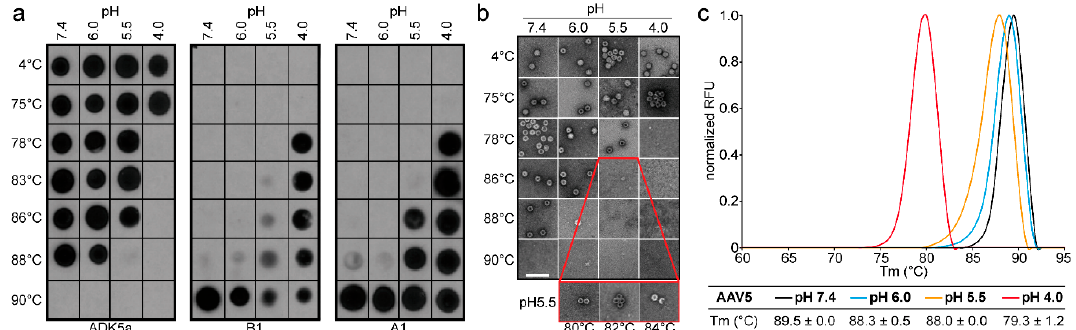
Figure 3. AAV5 stability analysis. ( a ) Dot immunoblots of AAV5-GFP vectors at different pHs representative of physiological (7.4), early endosomal (6.0), late endosomal (5.5), and lysosomal (4.0) conditions. The virus was heat-shocked at the temperature indicated and blotted for intact capsids (ADK5a), denatured capsids (B1), and the accessibility of VP1u (A1). ( b ) Negative-stain EM of AAV5-GFP vectors treated as in ( a ). Scale bar: 100 nm. ( c ) T m of AAV5-VLPs determined by DSF at the pH conditions used in ( a ) and ( b ). A thermal profile for each pH condition is shown as normalized relative fluorescence units (RFUs) versus temperature (in ◦ C). All experiments were performed in triplicate.